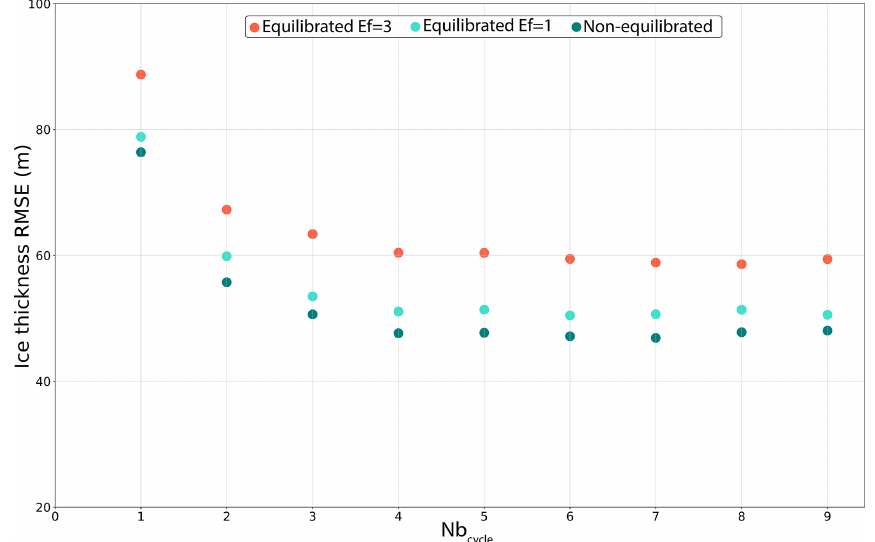
Figure 13. Ice thickness root mean square error with regard to observations from Bamber et al. (2013), in metres, for Nb inv = 20 years, Nb free = 200 years, as a function of the number of iterations (Nb inv ). Dark blue dots are for the experiment that uses the non-equilibrated temperature profile as initial condition and Ef = 3. Cyan and orange dots are for the experiments using the equilibrated temperature and Ef = 3 and Ef = 1 respectively.